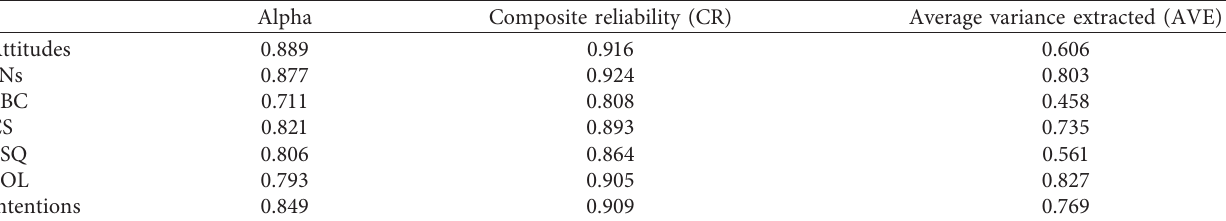
Table 3: Convergent